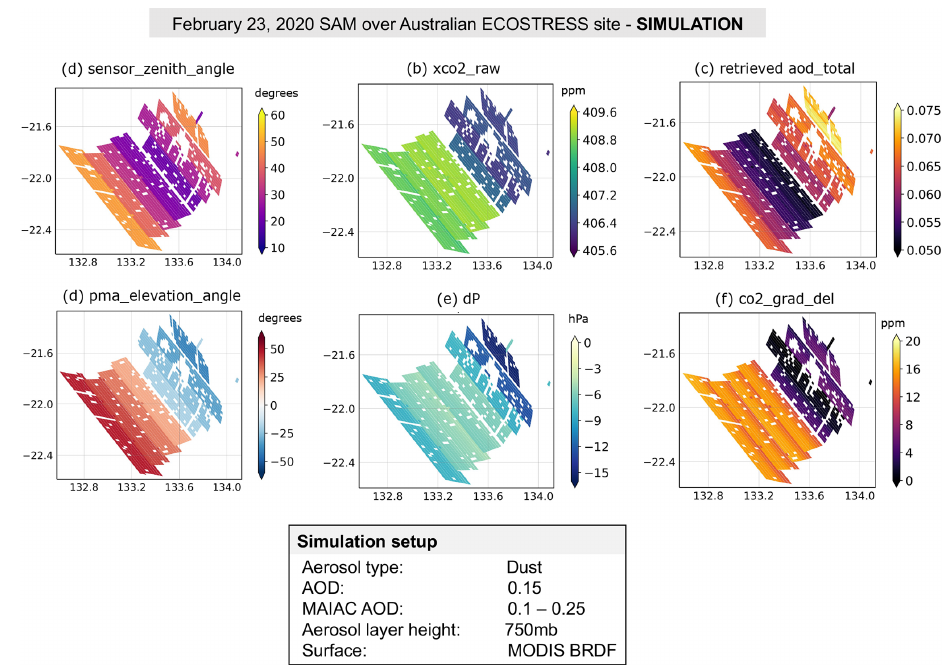
Figure 8. Maps of several retrieved parameters from our first simulation of the 23 February 2020 SAM over Australia.